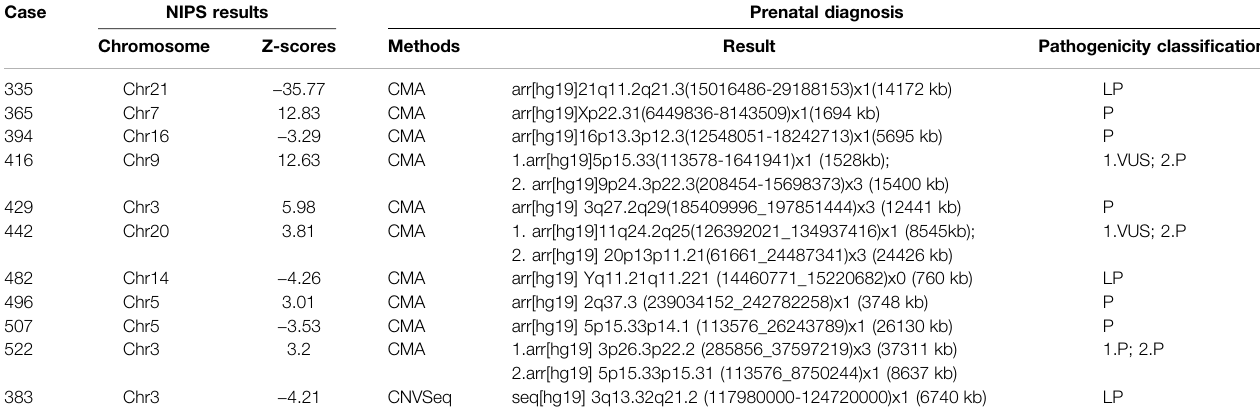
TABLE 6 | Likely pathogenic and pathogenic CNVs by CNV detection techniques in 11 cases with positive NIPS for other chromosomal abnormalities.